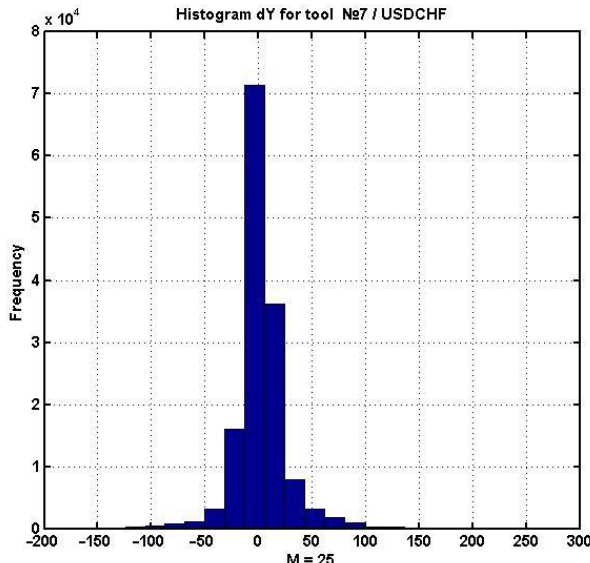
Figure 6. Histogram of smoothed d k.